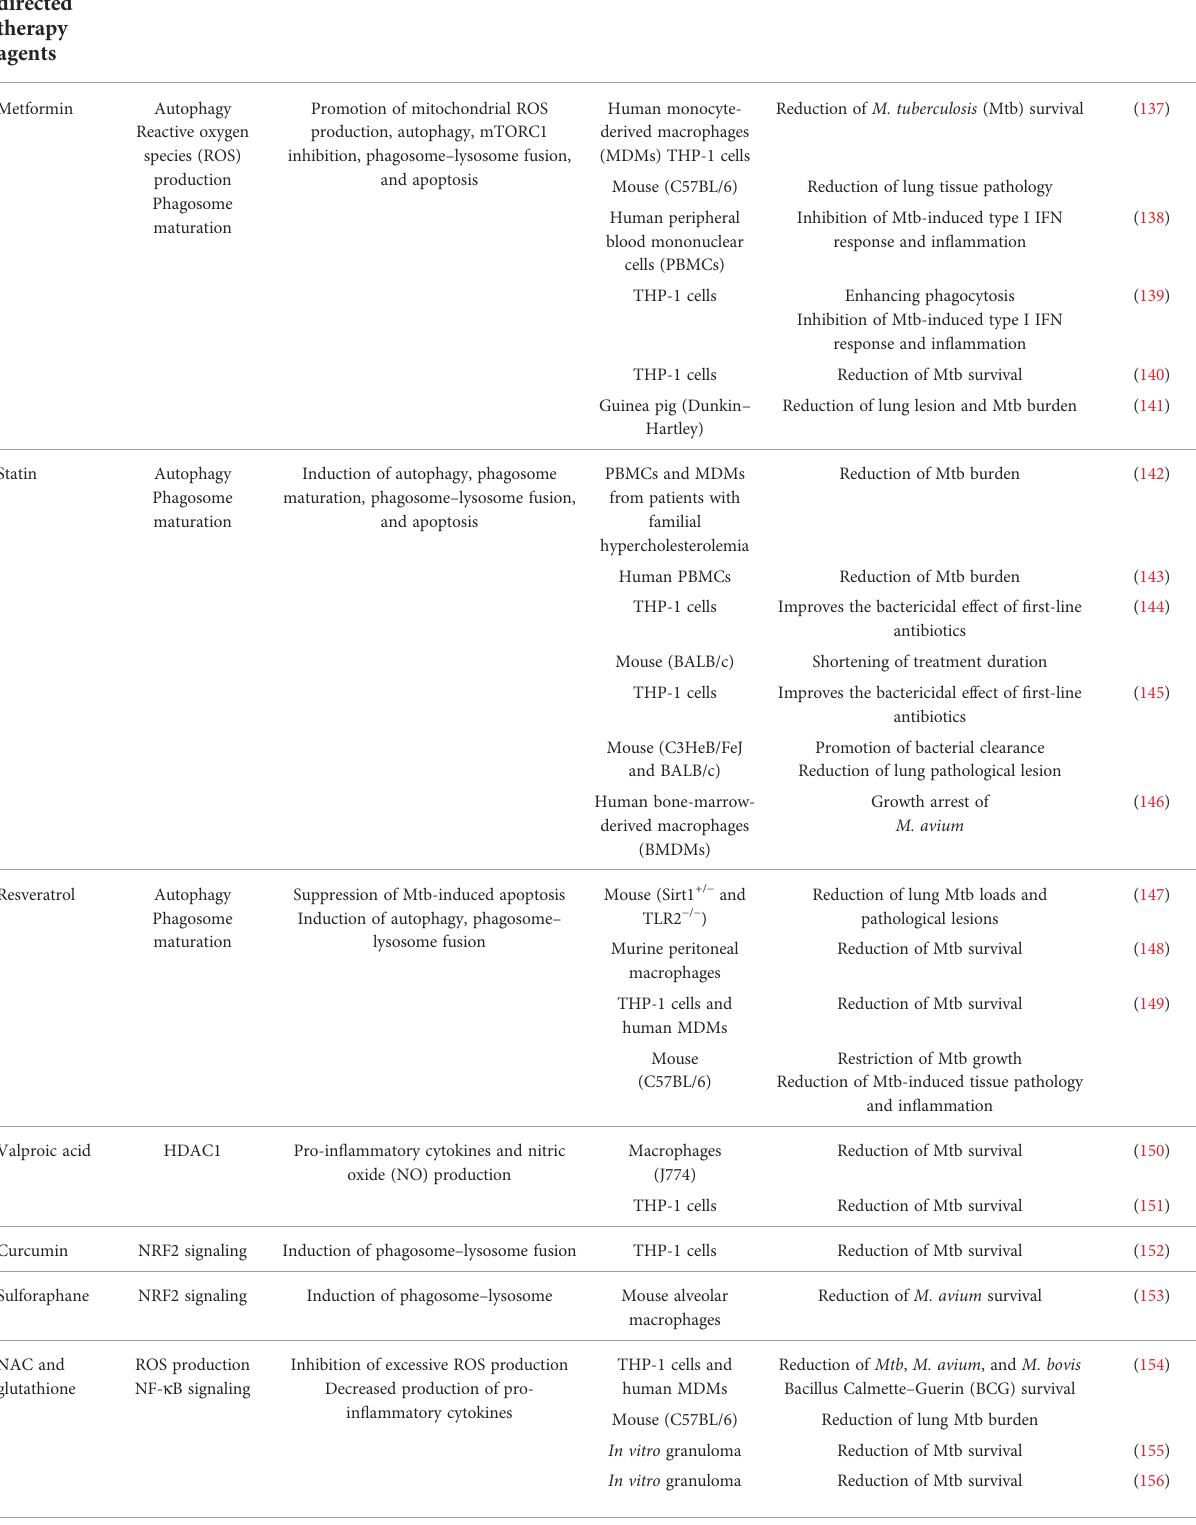
TABLE 2 Proposed list of potential host-directed therapeutics to modulate macrophage function against Mycobacterium avium complex infection.